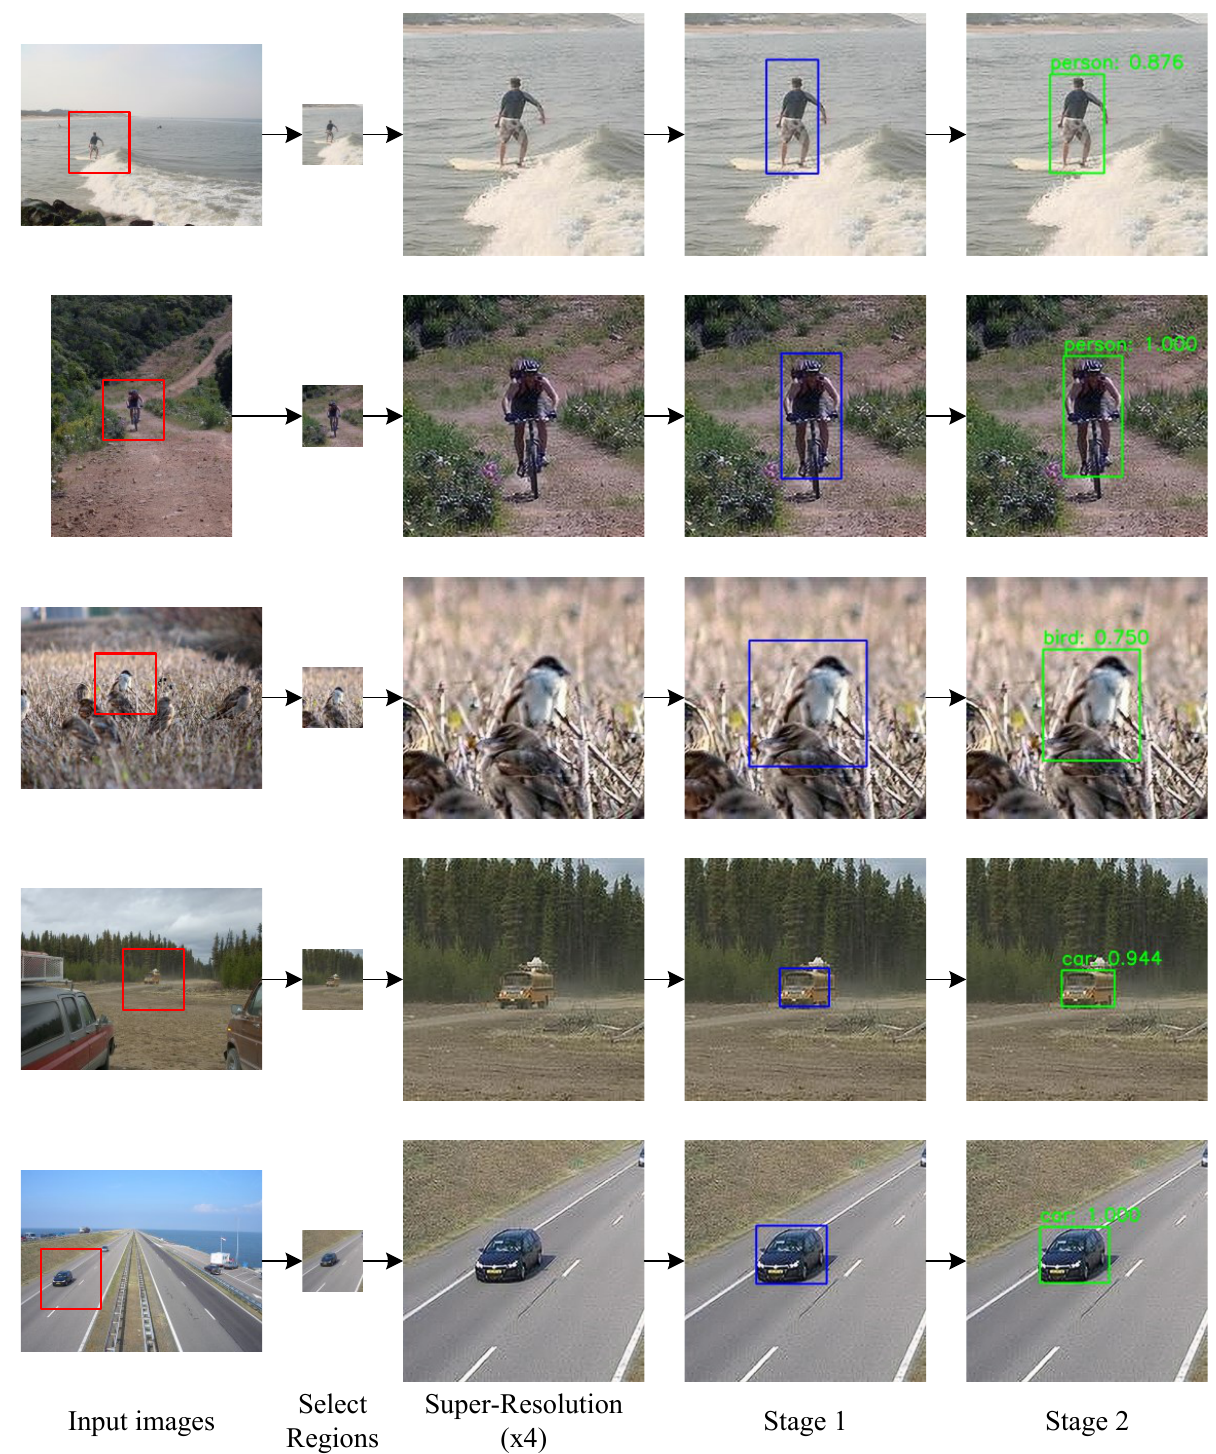
Figure 8. Two-stage object detection of